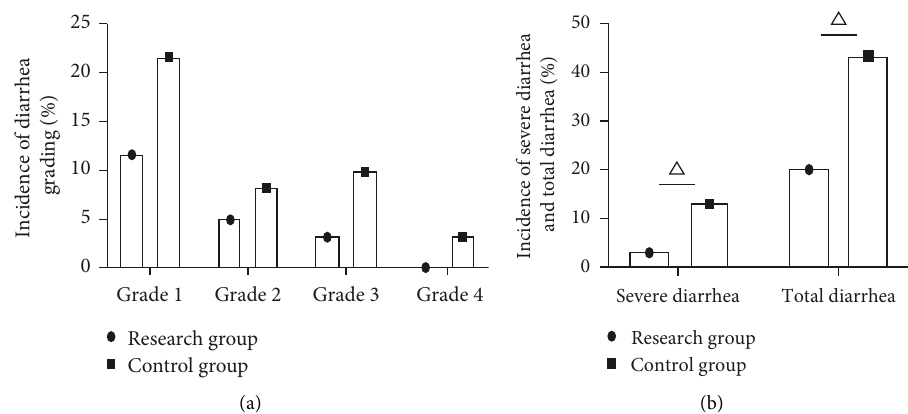
Figure 1: Comparison of incidence of IIDD for both groups. Note: Δ is the difference between the two groups, P < 0 . 05. (a) Incidence of diarrhea grading (%) and (b) incidence of severe diarrhea and total diarrhea (%).